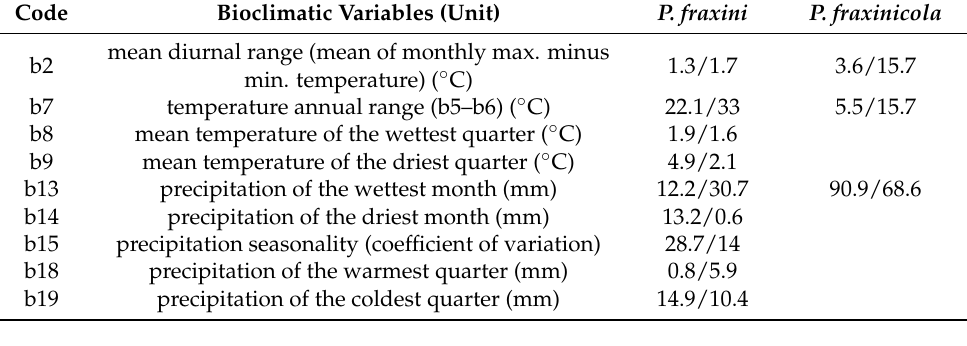
Table 3. Bioclimatic variables used in the Maxent model and their contribution/permutation impor- tance (in %) for Phyllactinia fraxini and P. fraxinicola . For a complete overview of bioclimatic variables, see Table 1.